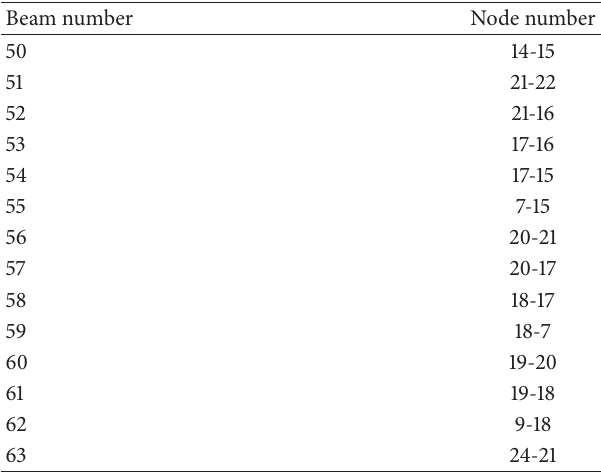
Table 1: Beam element connection